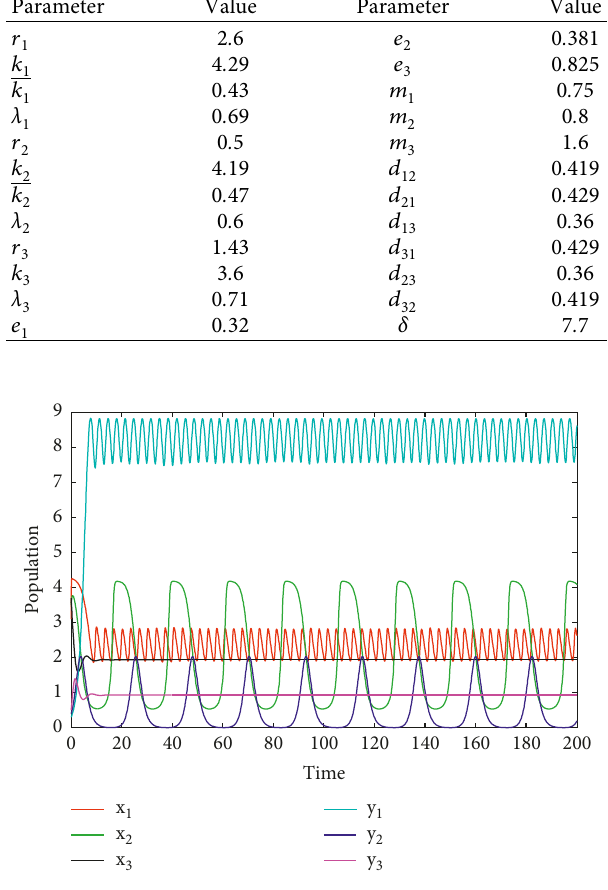
Figure 2: Unstable behavior of the proposed prey-predator system as time